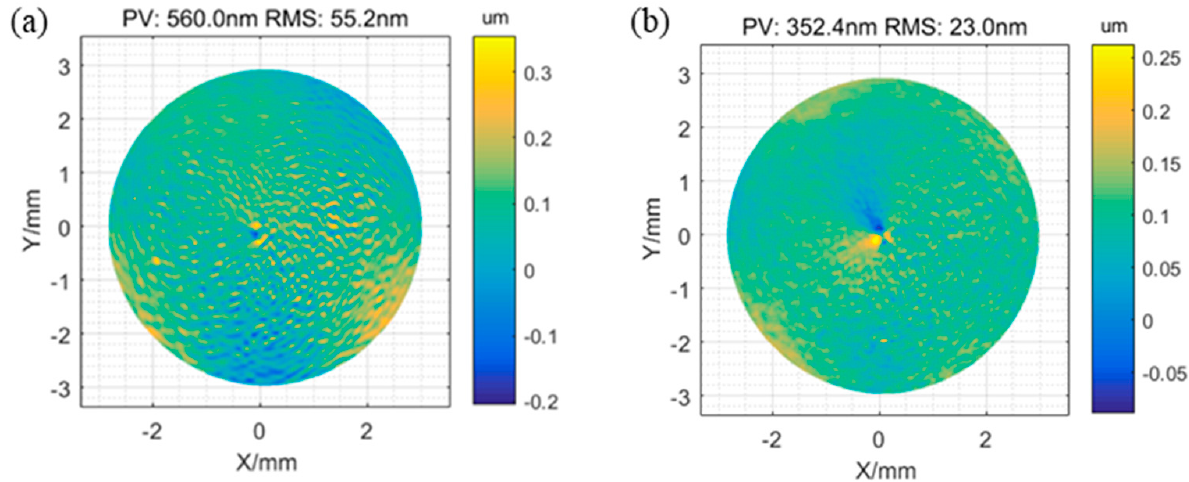
Figure 6. Freeform surface measured after first machining ( a ) and ( b ) the corresponding form error.